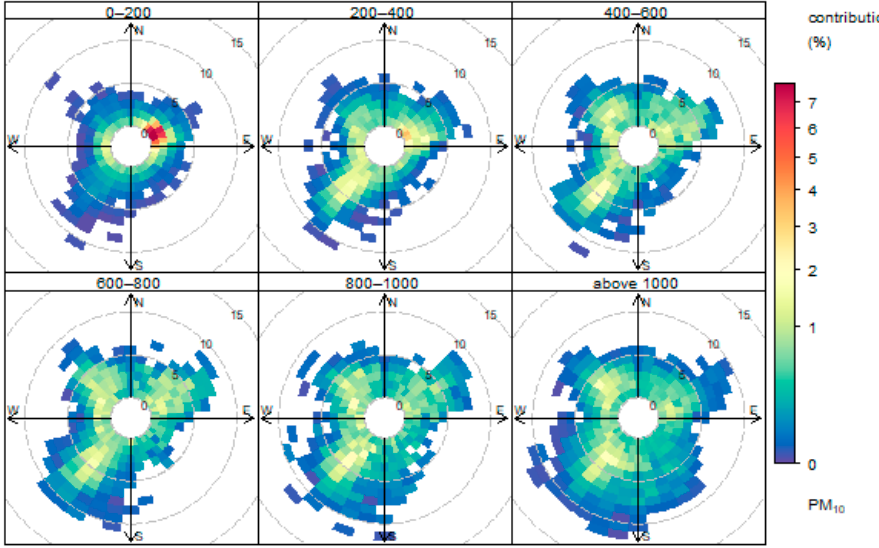
Figure 18. A weighted PM 10 concentration rose divided according to the mixing layer height, the V ěřň ovice site, 2016–2019.